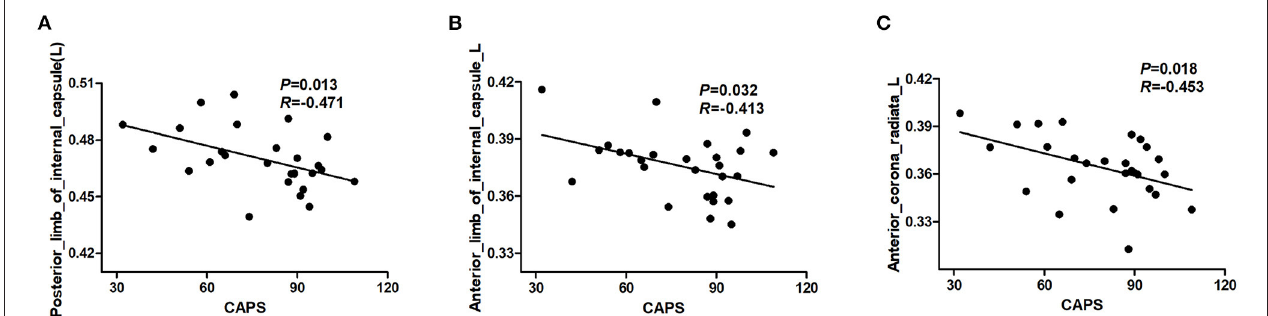
FIGURE 2 | Results of correlation analyses between abnormal FA regions and severity of PTSD symptom in individuals with PTSD. The CAPS score was negatively correlated with the FA value of the left posterior limb of the internal capsule (A) . The CAPS score was negatively correlated with the FA value of the left anterior limb of the internal capsule (B) . The CAPS score was negatively correlated with the FA value of left anterior corona radiata (C) ( P < 0.05, not corrected). PTSD, posttraumatic stress disorder; CAPS, Clinician-Administered PTSD Scale; FA, fractional